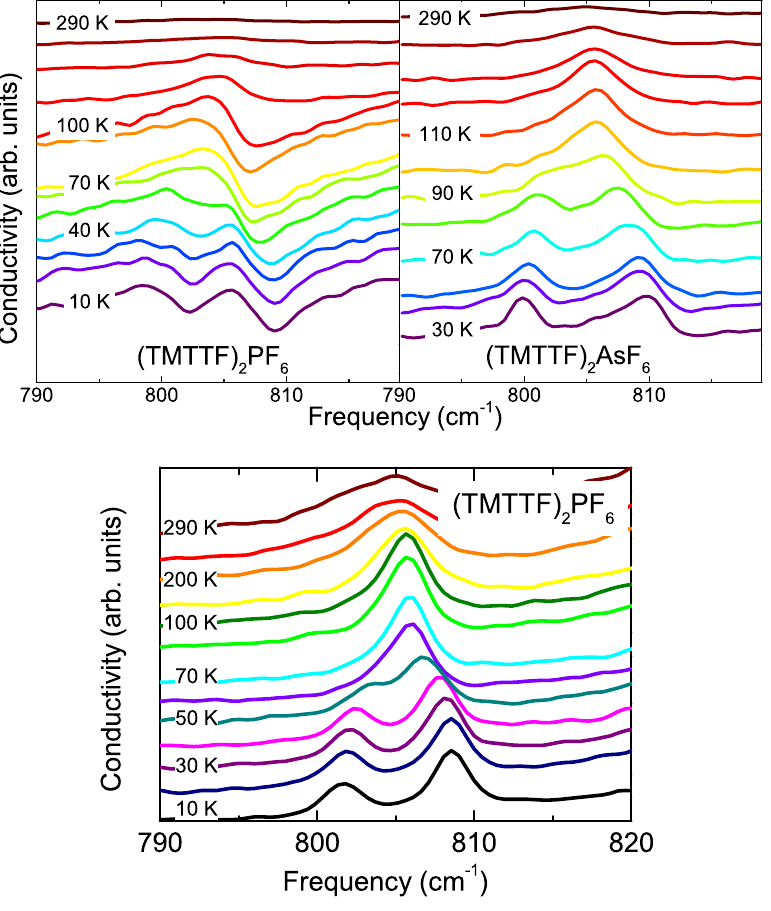
modes of the TMTTF molecule calculated by g